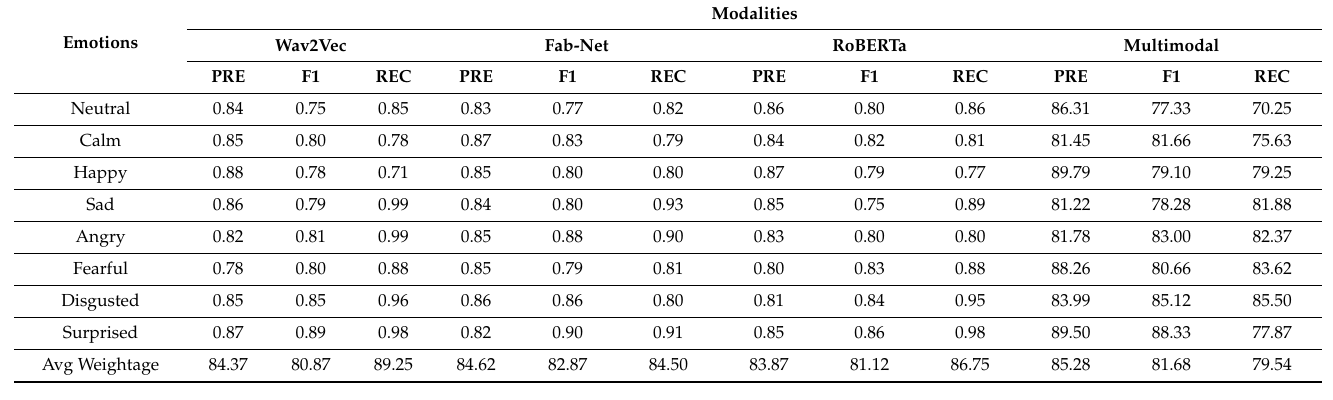
Figure 6 represents the plot of the confusion matrix for eight emotion categories that included sad, calm, fear, surprise, angry, happy, neutral, and disgust.